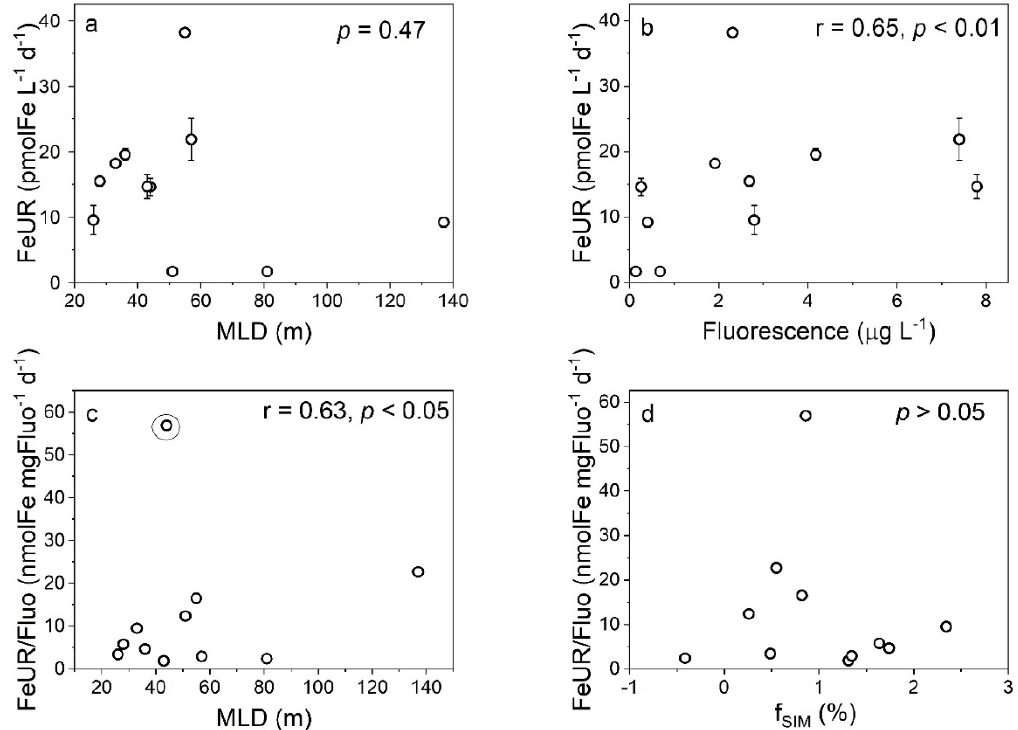
Figure 11. The relationships between the FeUR and the MLD ( a ) and phytoplankton biomass (expressed as fluorescence ( b ) and between the biomass-normalized FeUR and the MLD ( c ) and f SIM ( d ).